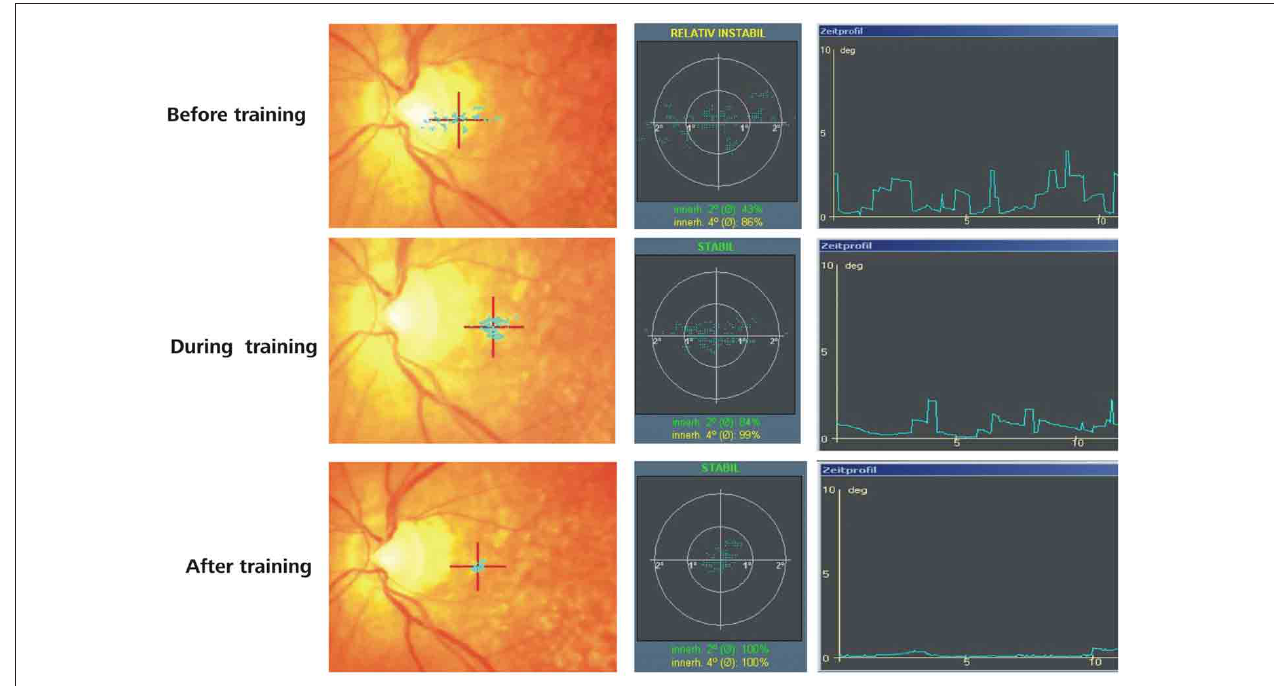
FIGURE 3 | Results of microperimetry and fixation stability measurements. An example is given for the development of fixation stability over training in a typical AMD Patient. The PRL is located at the red cross.